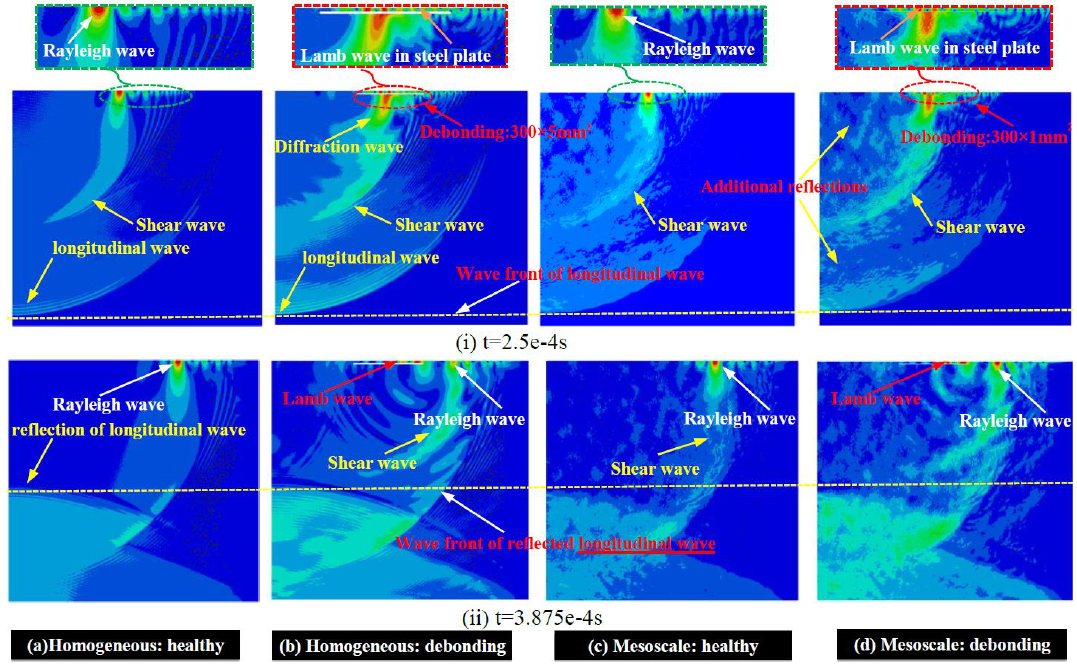
Figure 9. Wave fields comparison between the mesoscopic and homogenized models.